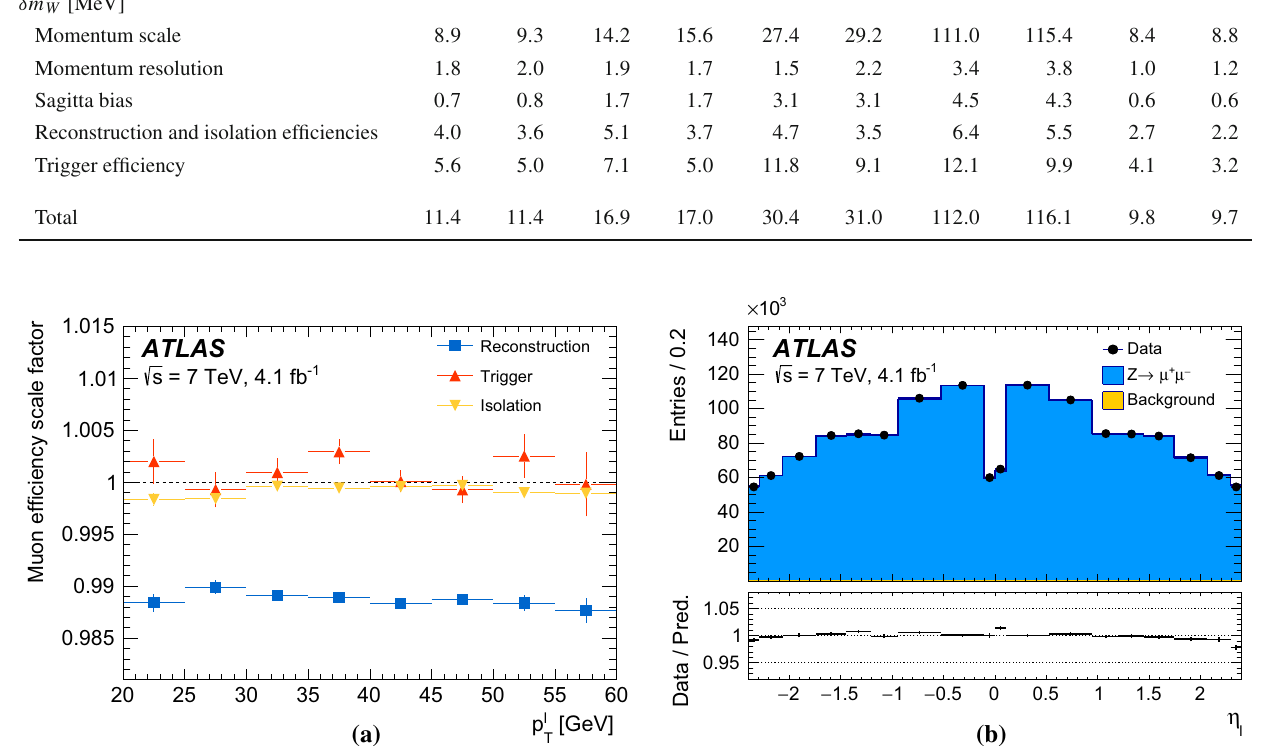
simulation including signal and background contributions. Corrections for momentum scale and resolution, and for reconstruction, isolation, and trigger efficiencies are applied to the muons in the simulated events. Background events contribute less than 0.2% of the observed distribu- tion. The lower panel shows the data-to-prediction ratio, with the error bars showing the statistical uncertainty